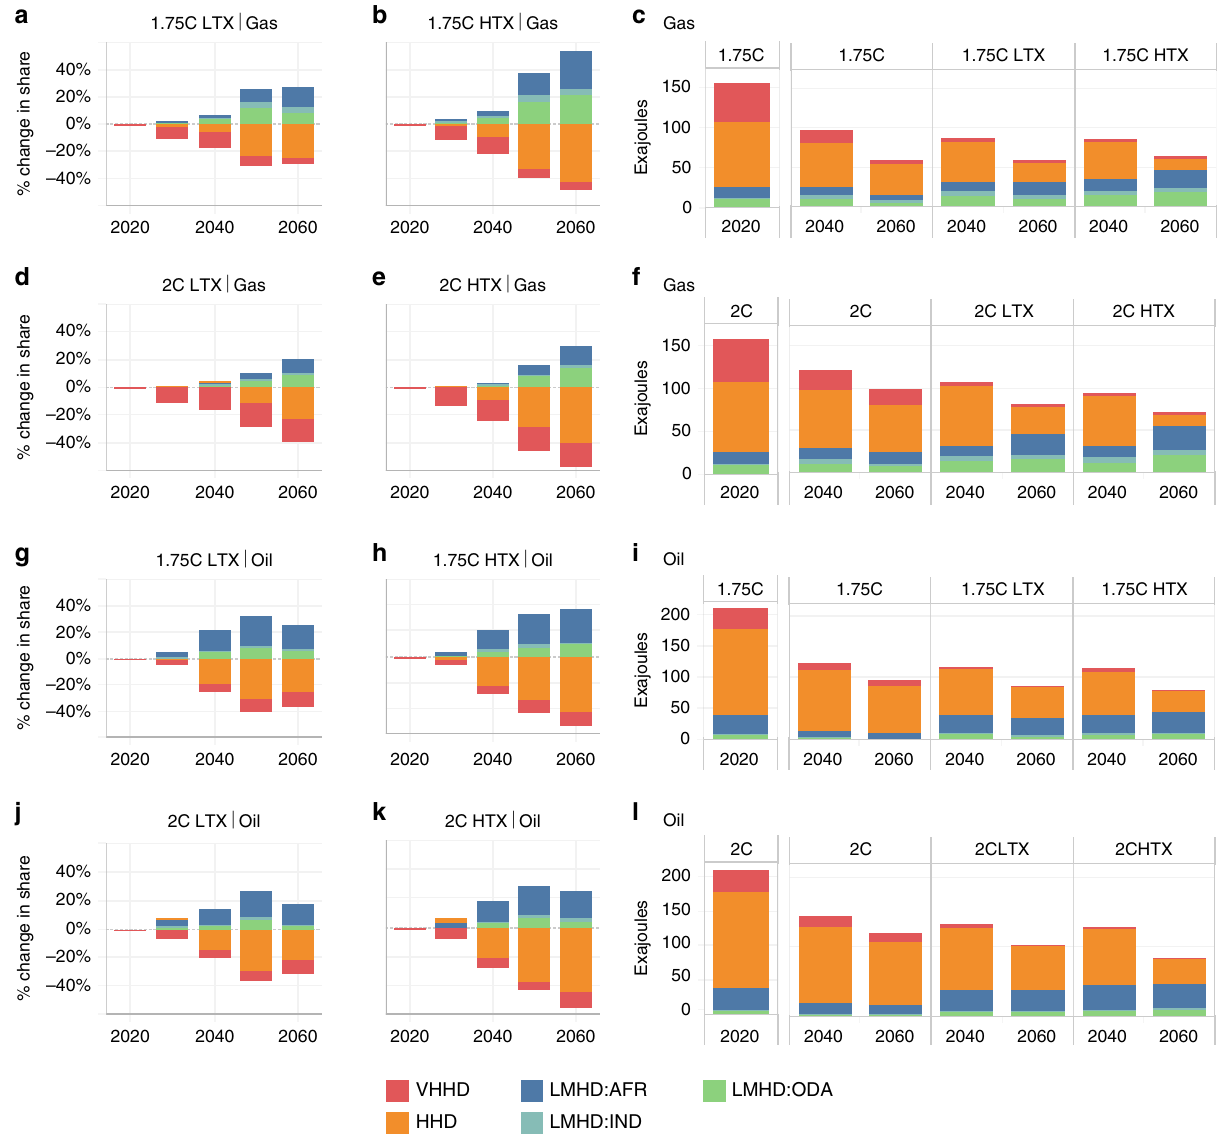
Fig. 1 Change in production levels of fossil fuels under 1.75 and 2 °C redistributed cases relative to the cost-optimal case, 2020 – 2060. The left hand panel shows the annual % change in production for a region relative to total global production under the cost-optimal case. Panels ( a , b ) and ( d , e ) show the change in gas production under low (LTX) and high tax (HTX) levels for 1.75 °C and 2 °C cases, respectively. Panels ( g , h ) and ( j , k ) show the same information for oil production. A positive change re fl ects a gain in total production in the given region, where, for example, 20% re fl ects an increase share equivalent to 20% of global production in the cost-optimal case. The right hand panel shows the absolute production levels, necessary for putting the percentage changes (left hand panel) in context. Panels ( c ) and ( f ) show the gas production level under low and high tax levels for 1.75 and 2 °C cases, respectively. Panels ( i ) and ( l ) show the same information for oil production. See Table 1 for the allocation of regions to the three HDI groups: VHHD, HHD, and LMHD. Source data are provided as a Source data fi